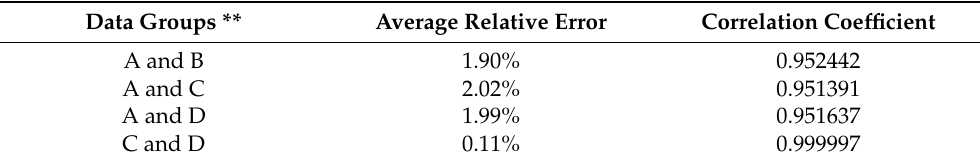
Table 1. Average relative error and correlation coefficient between observed and gridded data of Shanghai during the period of 1901 to